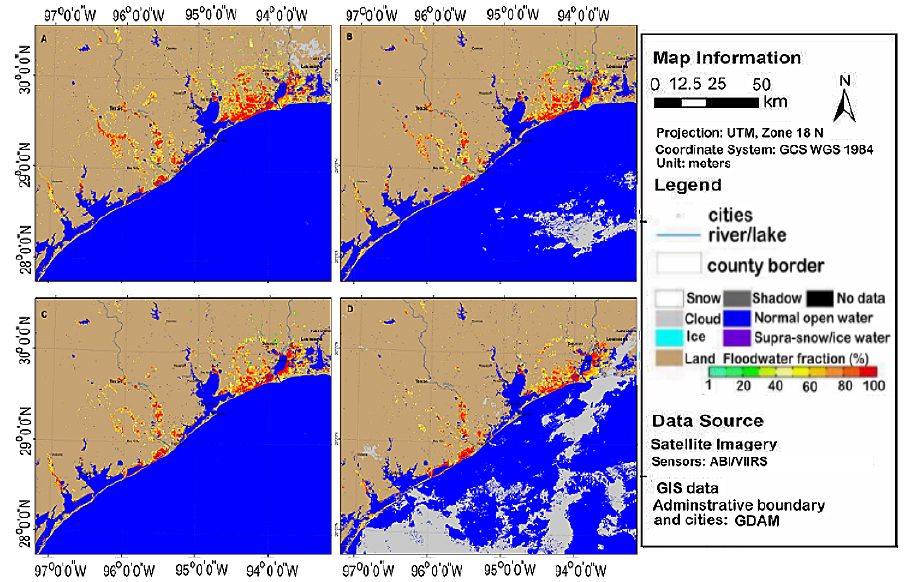
Figure 3. Flood maps integrated from GOES-16 ABI and SNPP VIIRS observations on ( A ) 31 August, ( B ) 1 September, ( C ) 2 September, and ( D ) 3 September 2017.